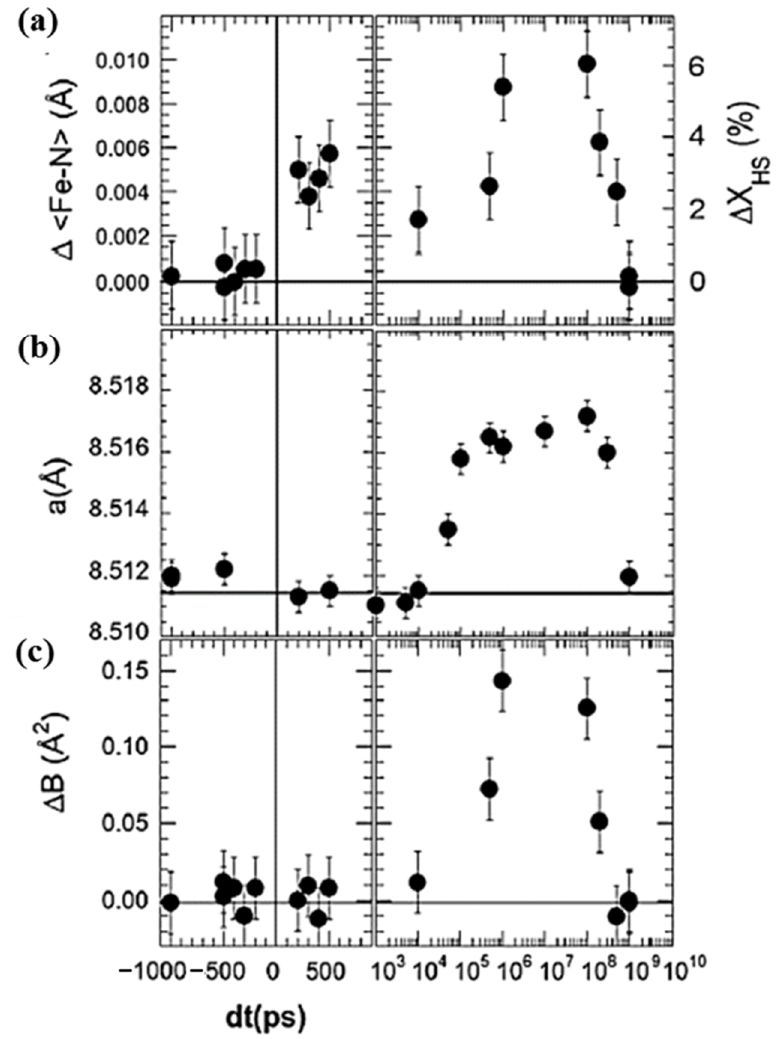
Figure 7. The time dependent structural change at 180 K for [(TPA)Fe(III)(TCC)]PF 6 . ( a ) The time-delay dependent average Fe–N bond length change Δ<Fe–N> and the deduced variation of ΔX HS . ( b ) the change in the lattice parameter <a> as a function of the time delay. ( c ) The isotropic temperature factor variation ΔB, as a function of the time delay. Reprinted with permission from Ref. [51]. Copyright 2009 by the American Physical Society.